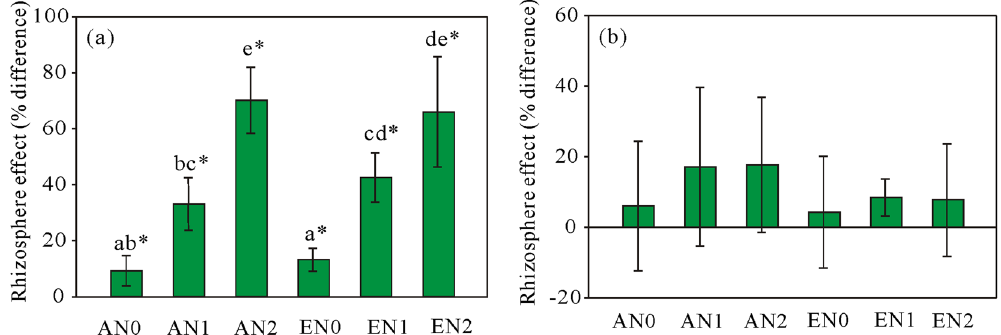
Figure 2. Rhizospheric effects for BR ( a ) and SIR ( b ) in the treatments. * Above each bar indicates significant difference between the rhizosphere and bulk soil. Different lowercase letters indicate significant differences in rhizospheric effects between treatments. AN0, ambient CO 2 and no N added; AN1 ambient CO 2 and N supply at a rate of 2.5 g N m − 2 y − 1 ; AN2, ambient CO 2 and N supply at a rate of 5 g N m − 2 y − 1 ; EN0, elevated CO 2 and no N added; EN1, elevated CO 2 and N supply at a rate of 2.5 g N m − 2 y − 1 ; EN2, elevated CO 2 and N supply at a rate of 5 g N m − 2 y − 1 .